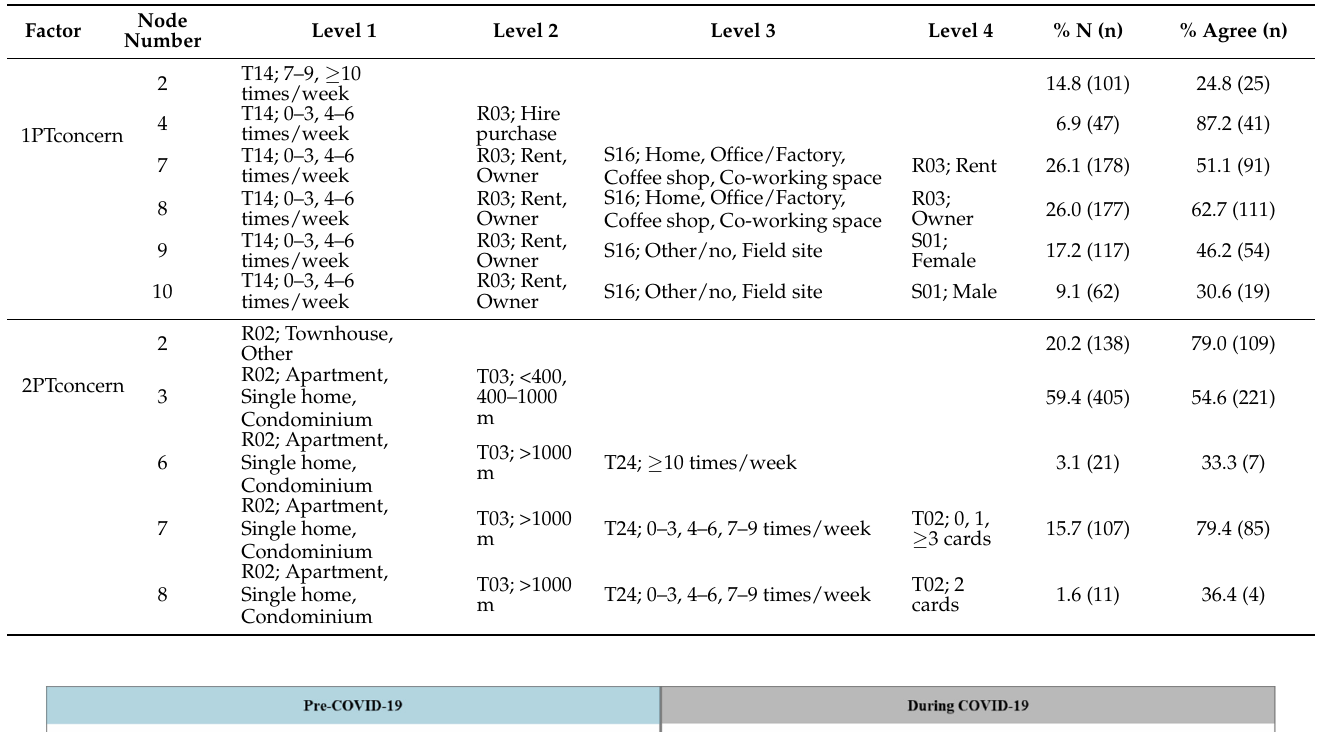
Table 8. Relevant segmentation of attitude toward concern about contracting infection from use of public transport and decision rule for terminal node.